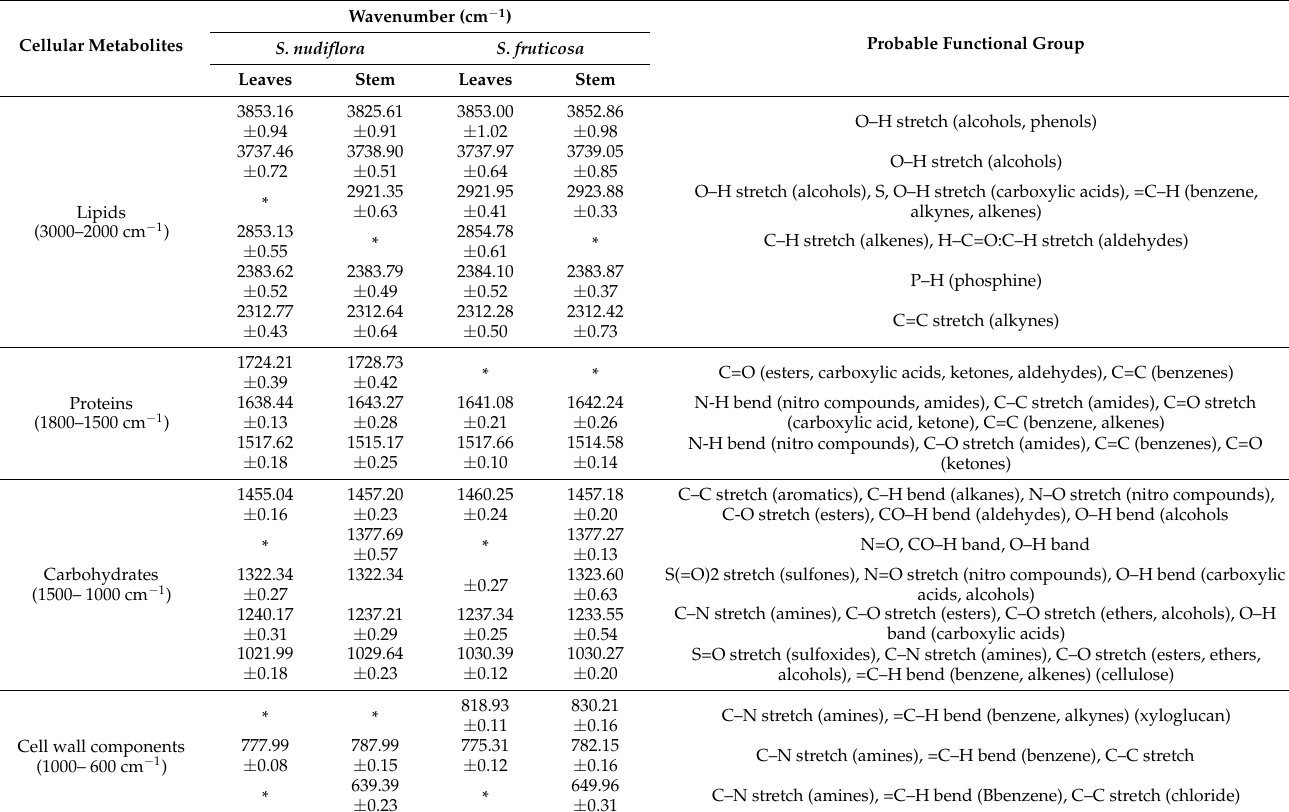
Table 5. FTIR spectra illustrating various peaks of functional groups in leaves and stem parts of the plants.